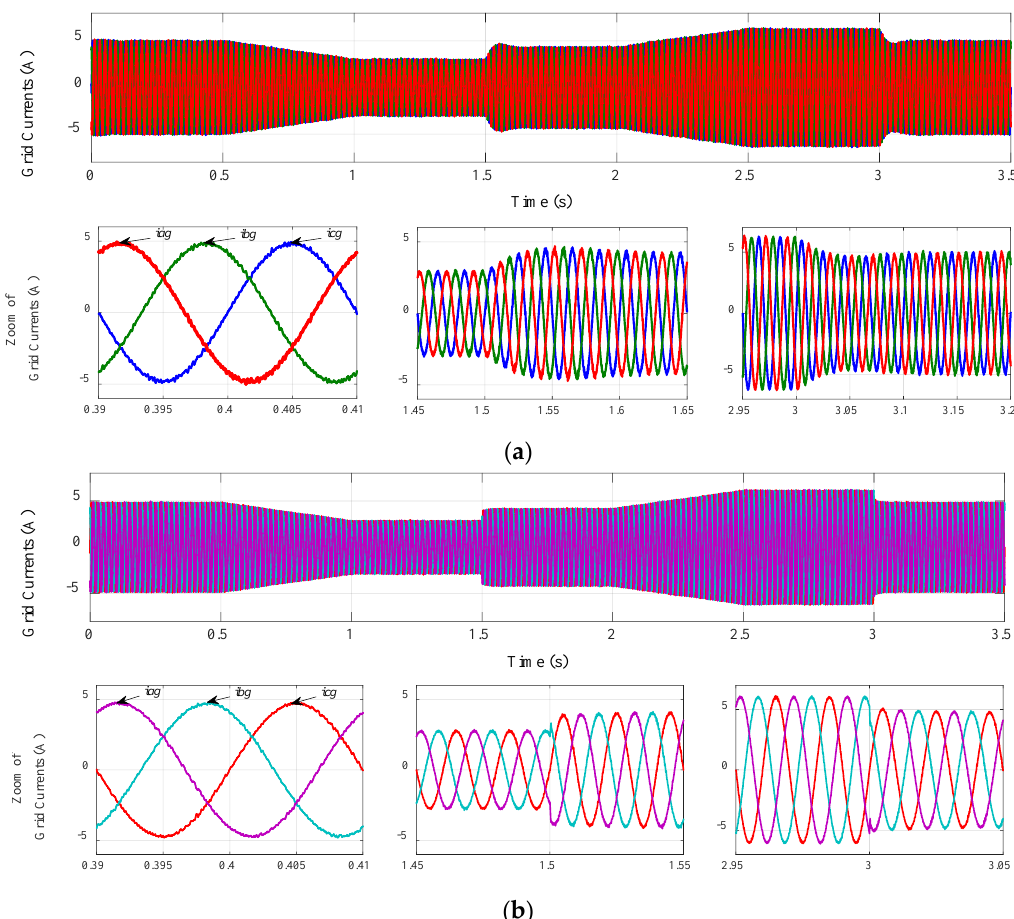
Figure 15. DC-Link voltage response with conventional and proposed methods.